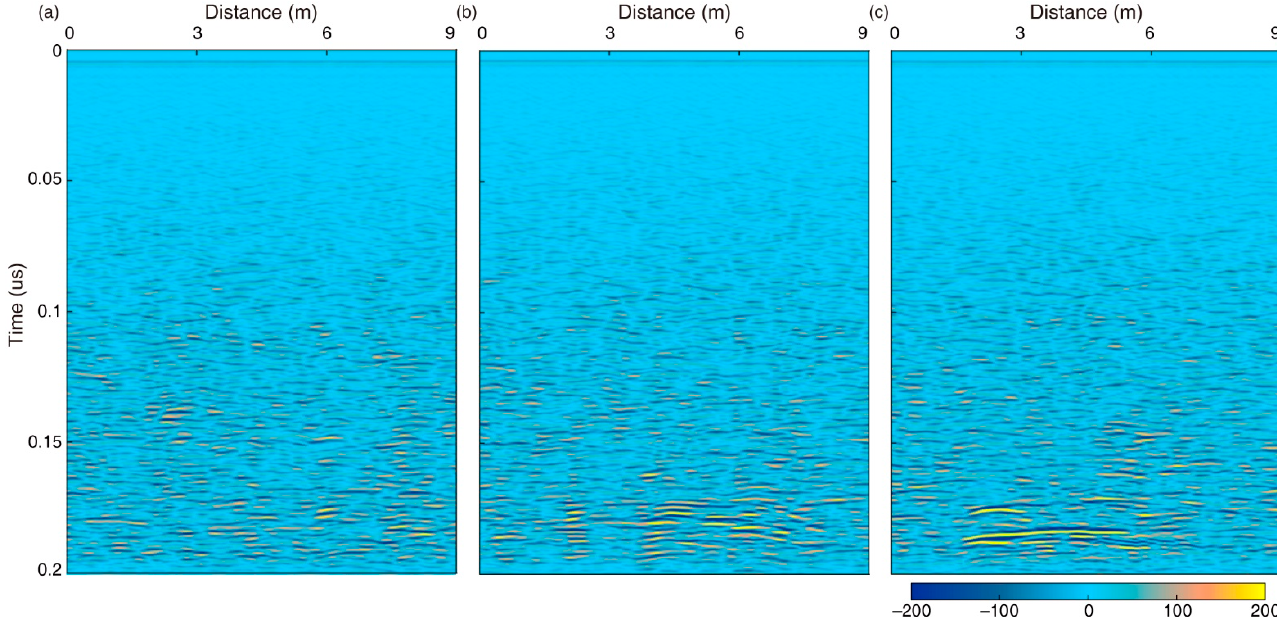
Figure 9. The ejecta model with small ( a ), medium ( b ), and large ( c ) spatial densities of rocks.